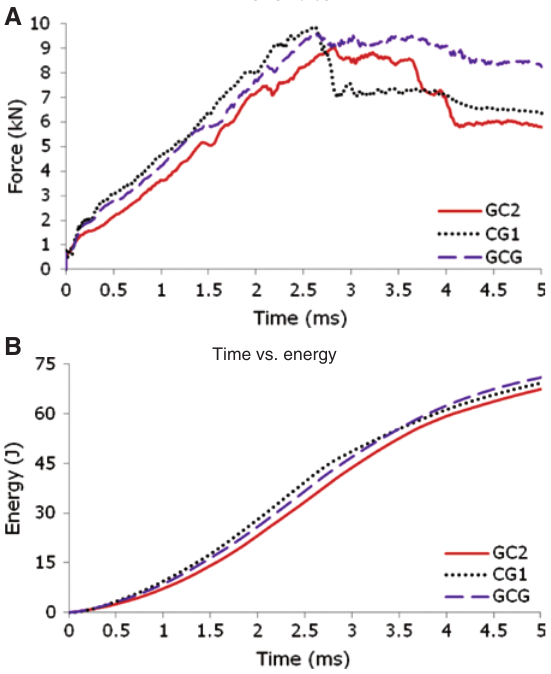
Figure 6: Time history plots of force and energy for different carbon fiber